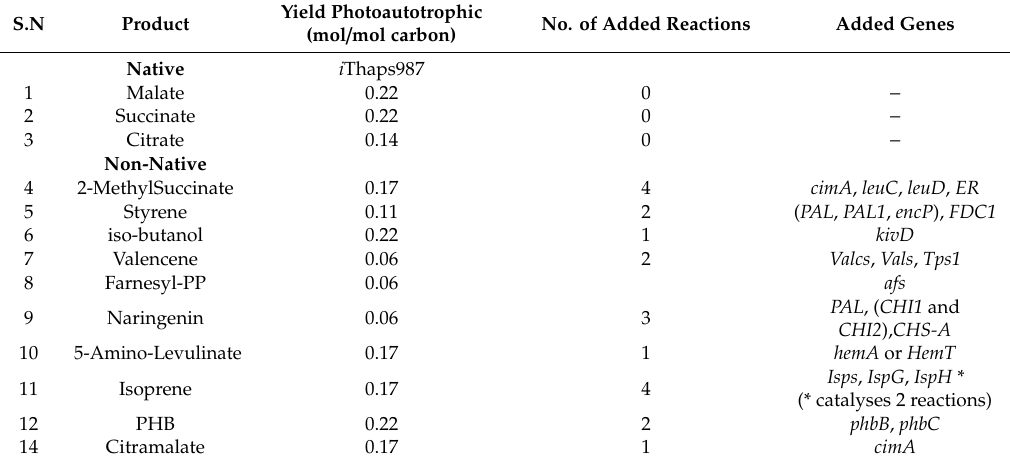
Table 3. Simulated maximum theoretical yields of various native and non-native products under photoautotrophic